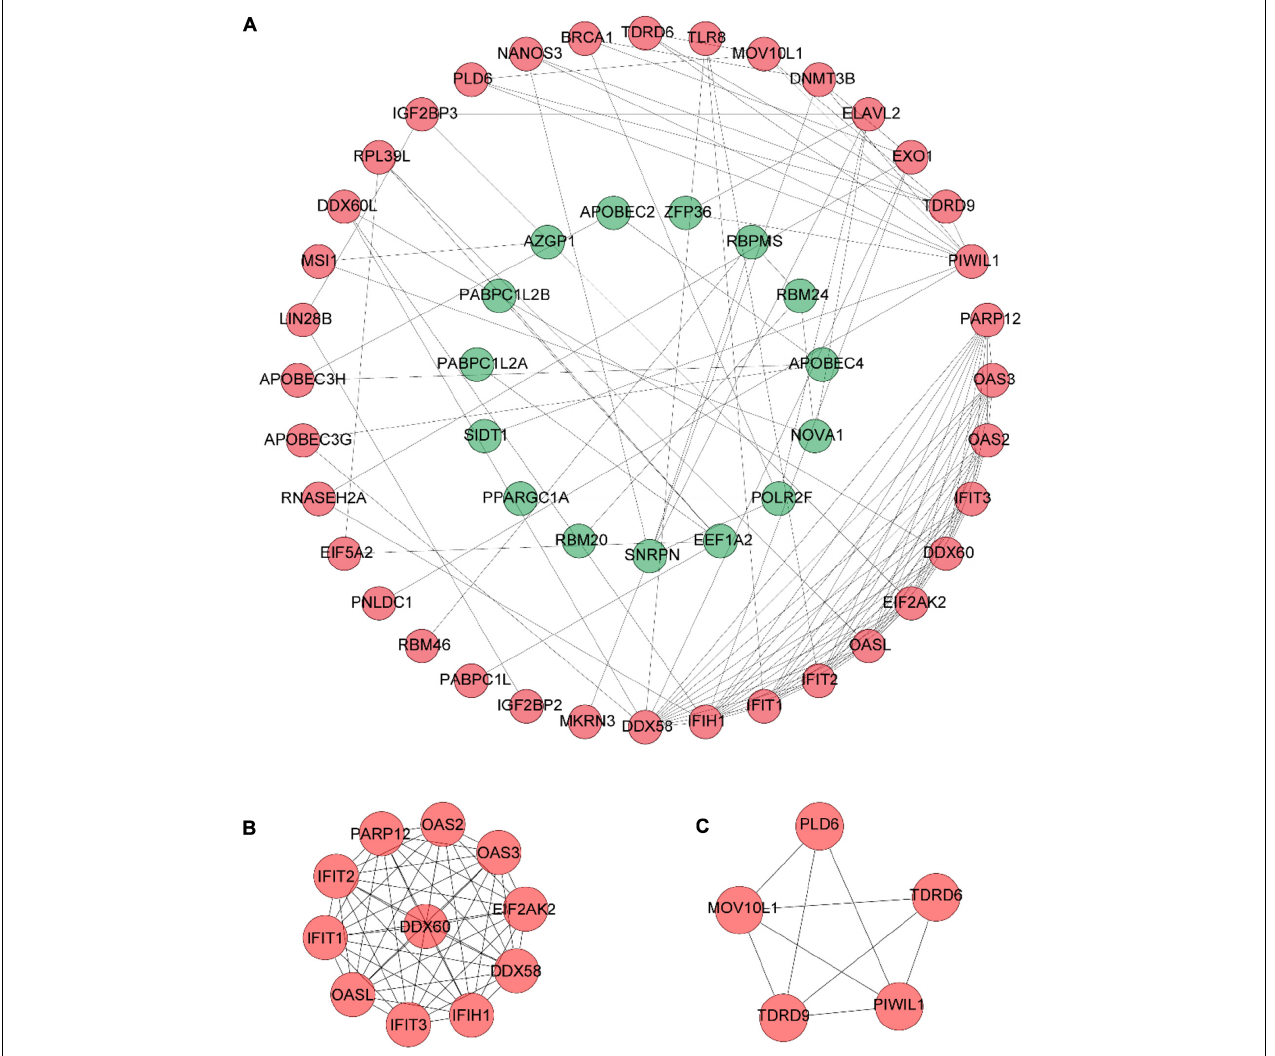
FIGURE 3 | PPI network construction. (A) PPI network constructed with the DERBPs of the TCGA data set. (B,C) The top two modules ( > 5 nodes), module 1 (B) and module 2 (C) , in the PPI network.